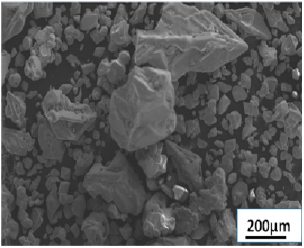
Figure 1. The SEM of NH 4 ReO 4 raw materials.